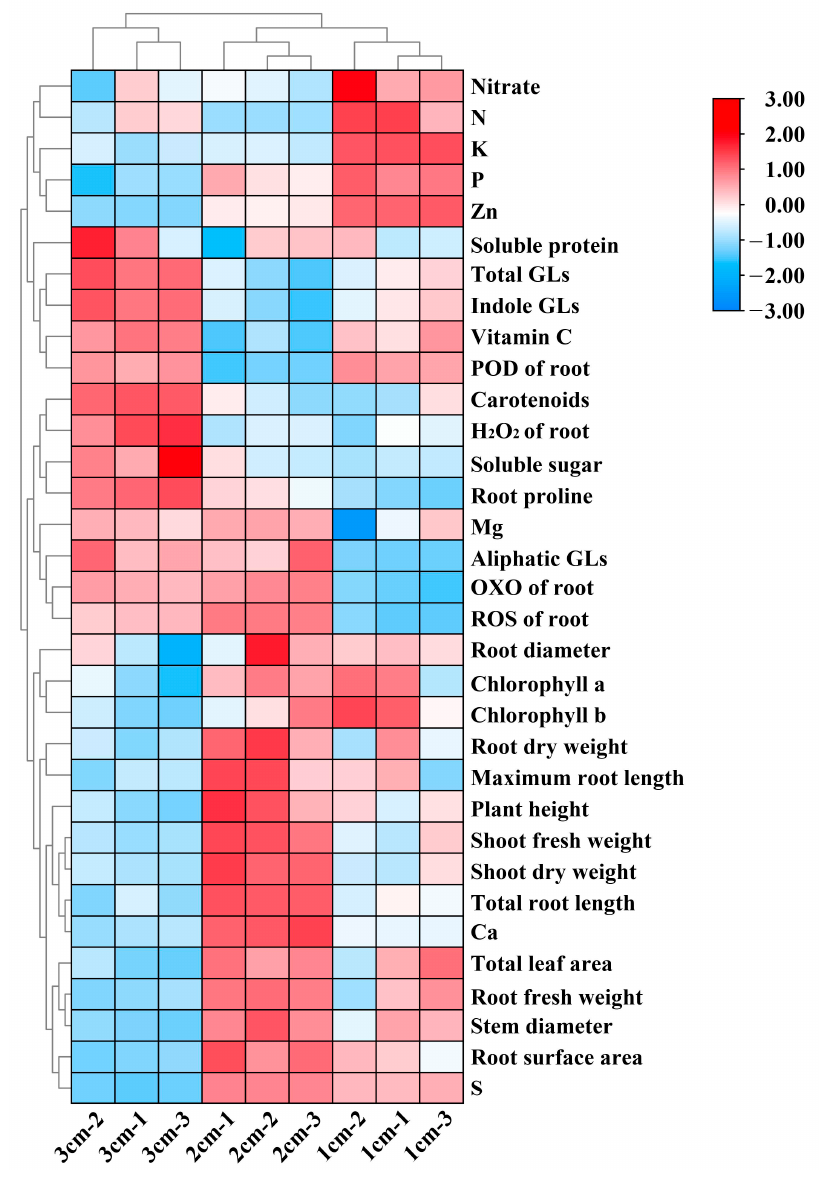
Figure 8. Cluster heat map analysis summarizing the growth and quality of kale grown under different nutrient-solution depths. Results are visualized using a false color scale with red as an increase parameter, while blue represents a decreased parameter.